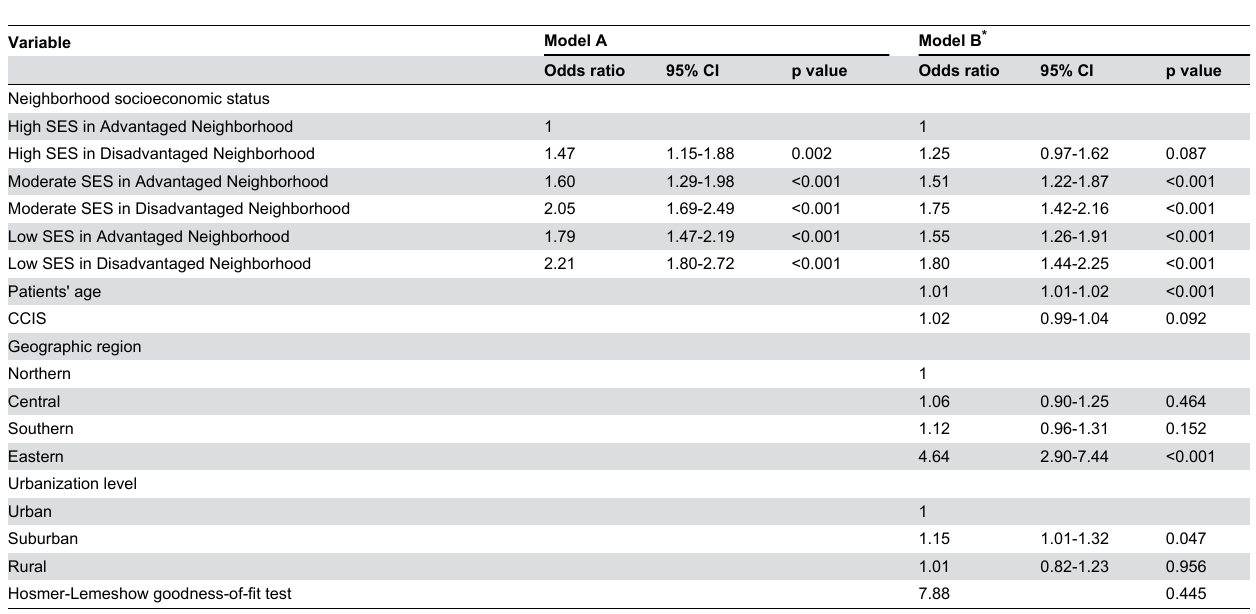
Table 3. Odds ratios of individual SES for low-volume surgeons in advantaged and disadvantaged neighborhoods.